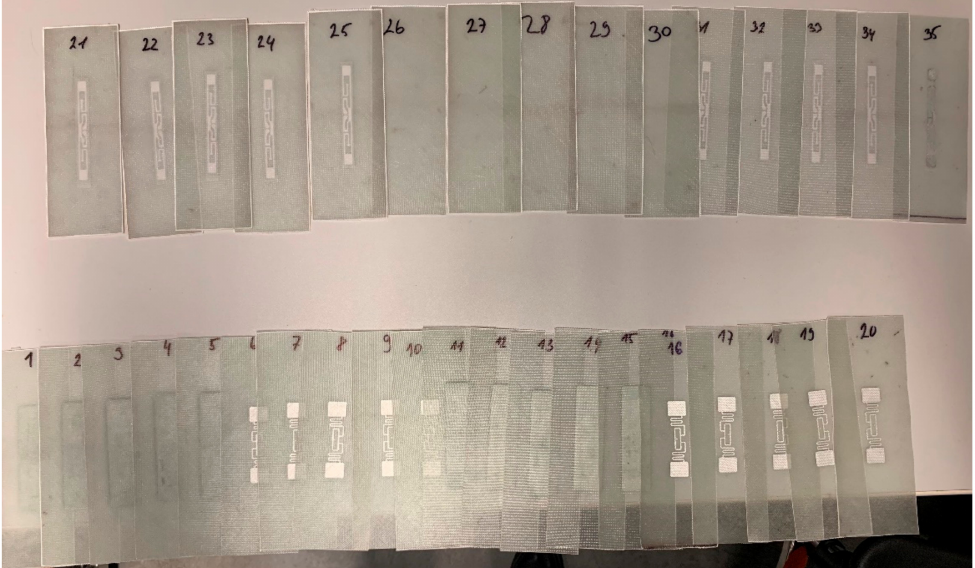
Figure 5. Laminated samples consisting of three series with different passive RFID tags integrated and one series without RFID